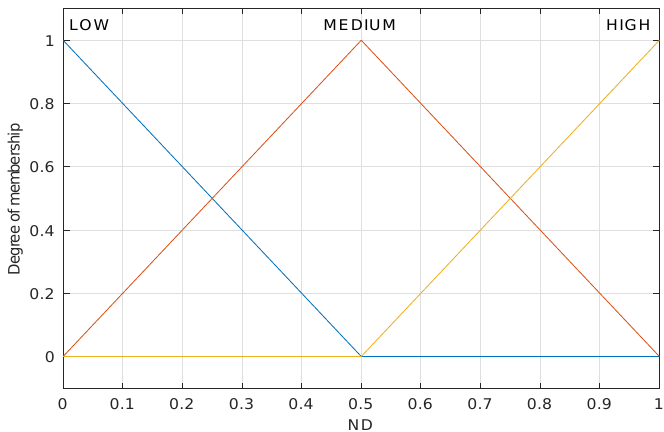
Figure 2. Membership function of ND.